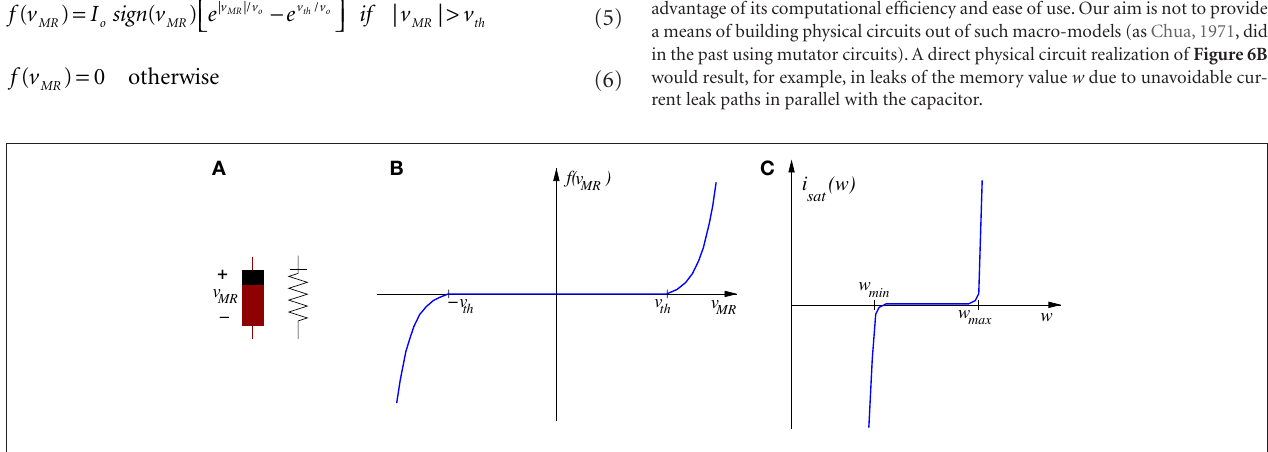
5 Note that our aim in providing a macro-model circuit is to have a means of simu- lating large number of memristors efficiently in a circuit simulator, and hence take advantage of its computational efficiency and ease of use. Our aim is not to provide a means of building physical circuits out of such macro-models (as Chua, 1971, did